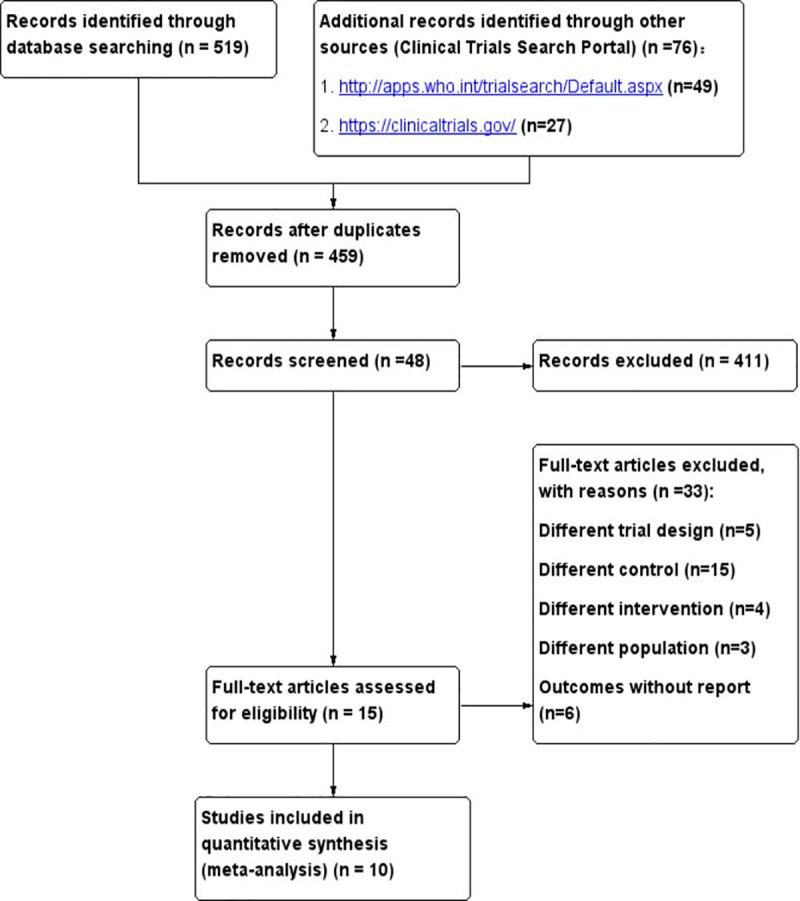
Literature search and screening process.